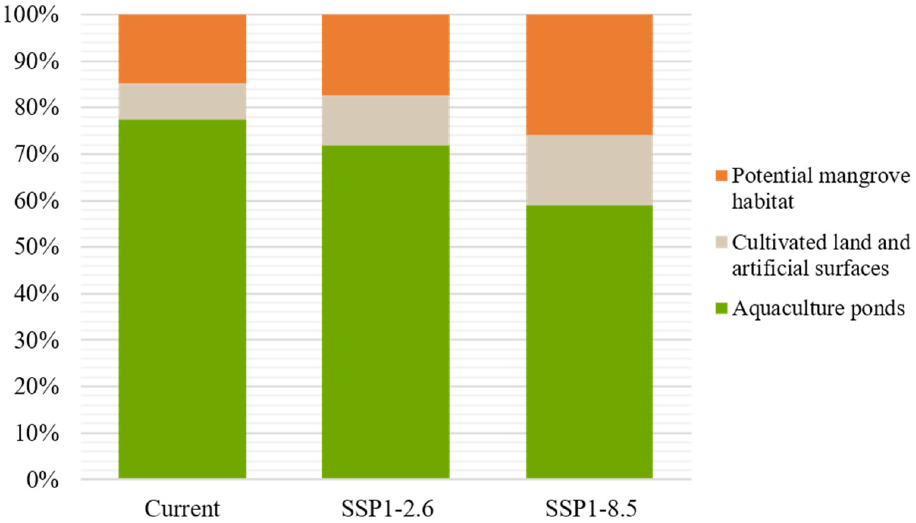
Figure 7. Overlap of cultivated and artificial surfaces and aquaculture with current and future mangroves suitable habitats.